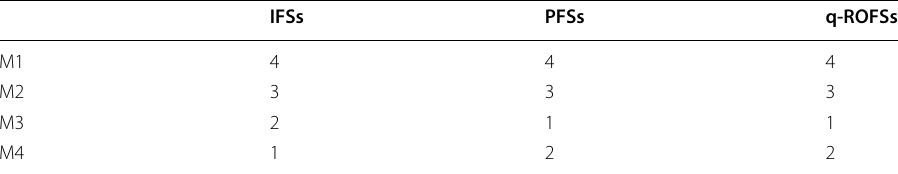
Table 15 Comparative model weighting priorities